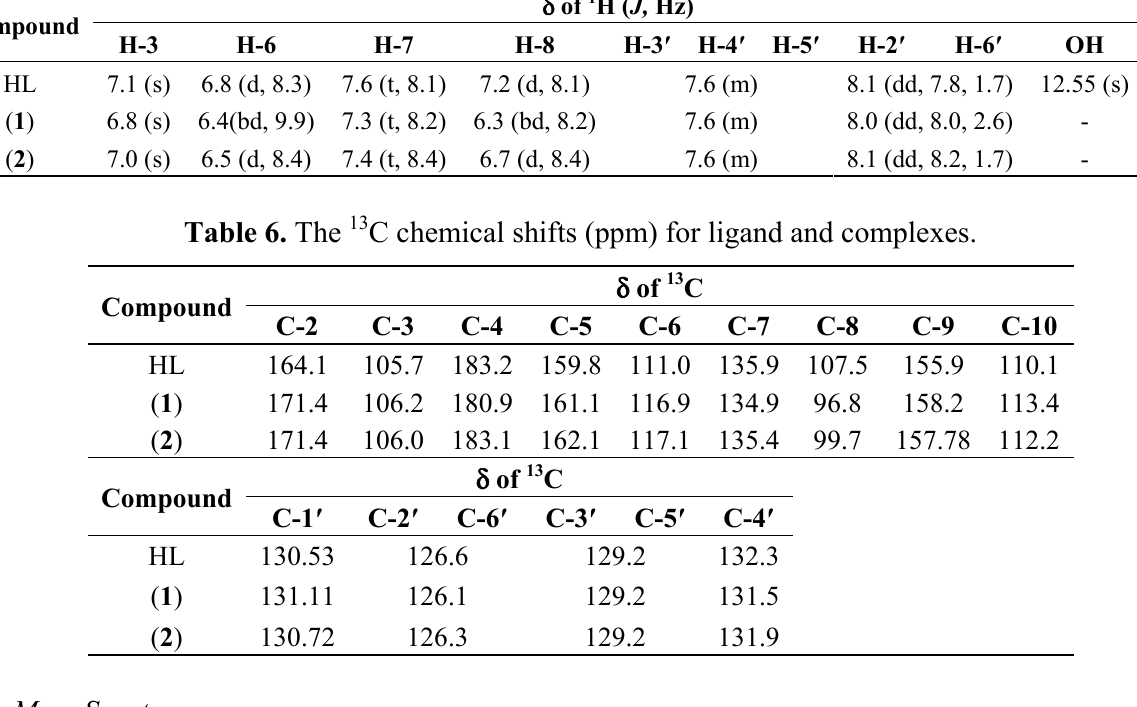
(Table 7). The data from the mass spectra suggest the 1:2 molar ratio metal